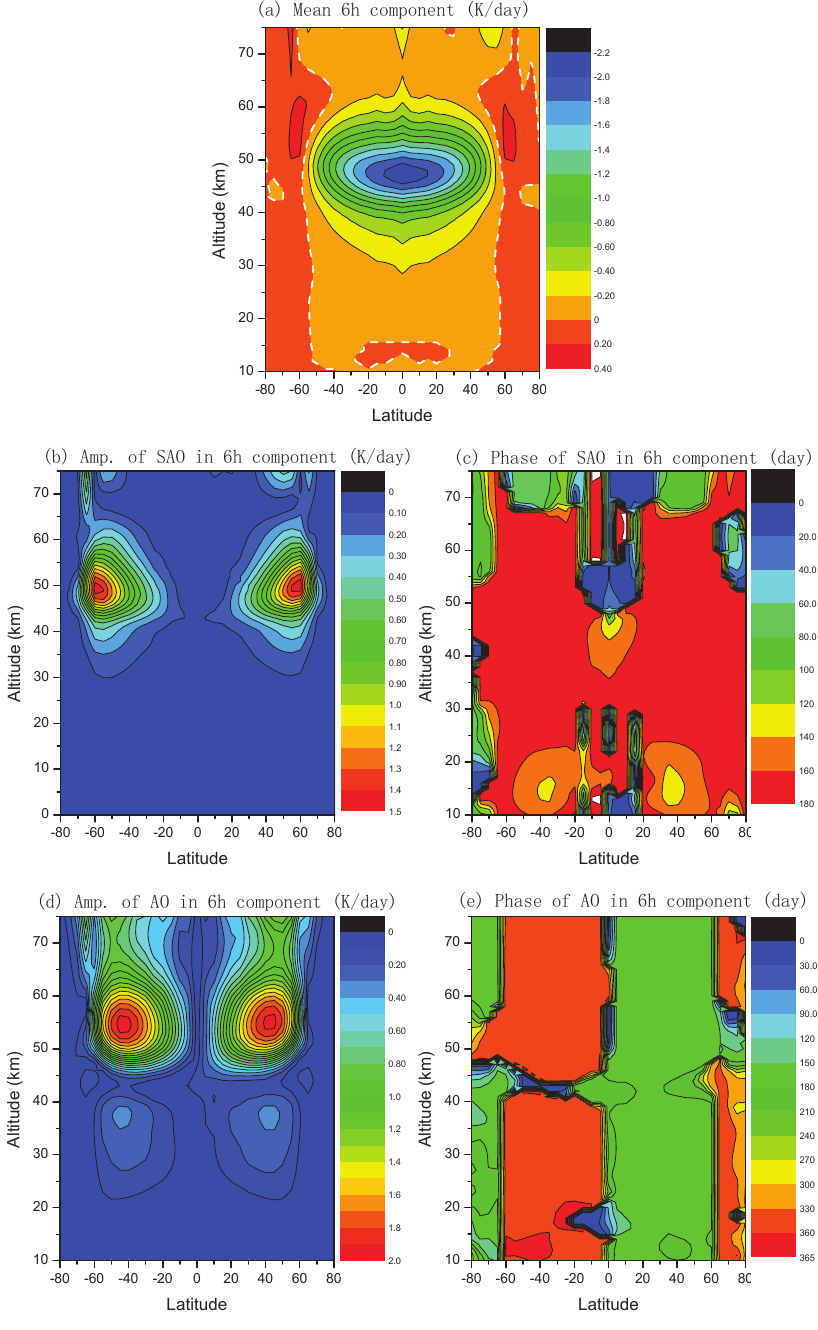
Fig. 16. The same as Fig. 9, but for 6-h component.